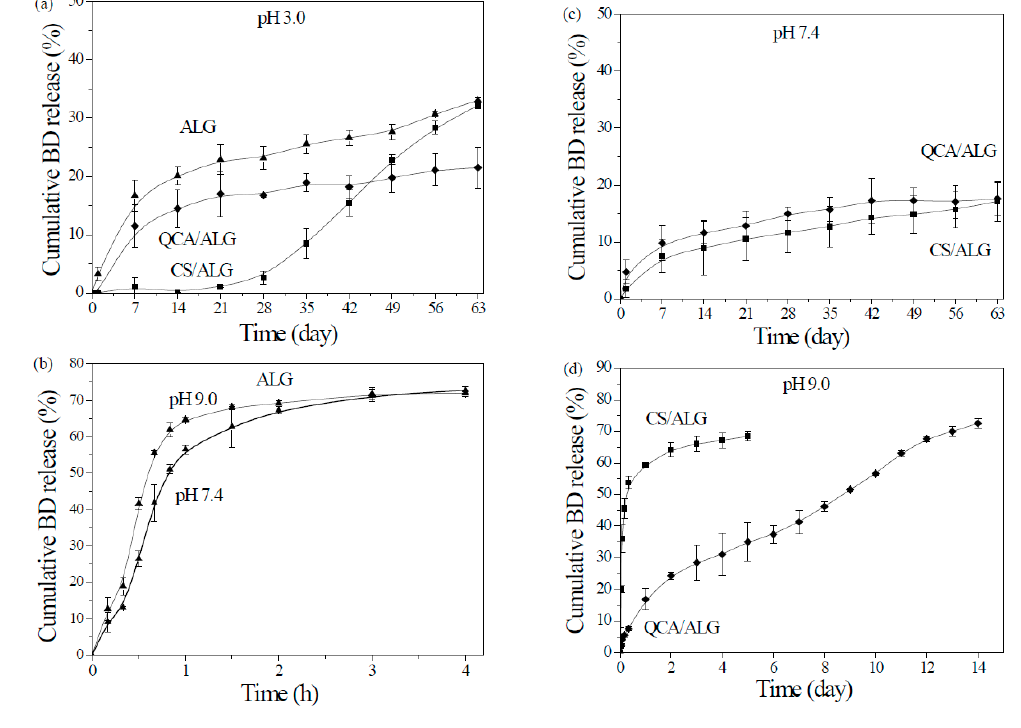
Figure 6. Release profiles of BD from different microspheres at different pH: ( a ) ALG ( (cid:78) ), CS/ALG ( (cid:4) ) and QAC/ALG ( (cid:7) ) microspheres at pH 3.0; ( b ) ALG ( (cid:78) ) microspheres at pH 7.4 and 9.0; ( c ) CS/ALG ( (cid:4) ) and QAC/ALG ( (cid:7) ) microspheres at pH 7.4; and ( d ) CS/ALG ( (cid:4) ) and QAC/ALG ( (cid:7) ) microspheres at pH 9.0.